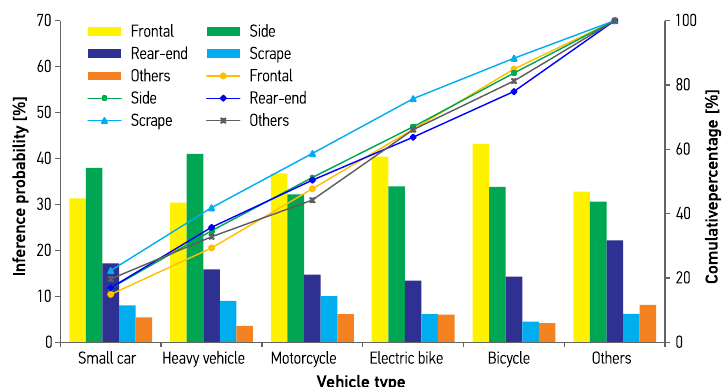
Fig. 7. Inference results of crash types (evidence: vehicle type)